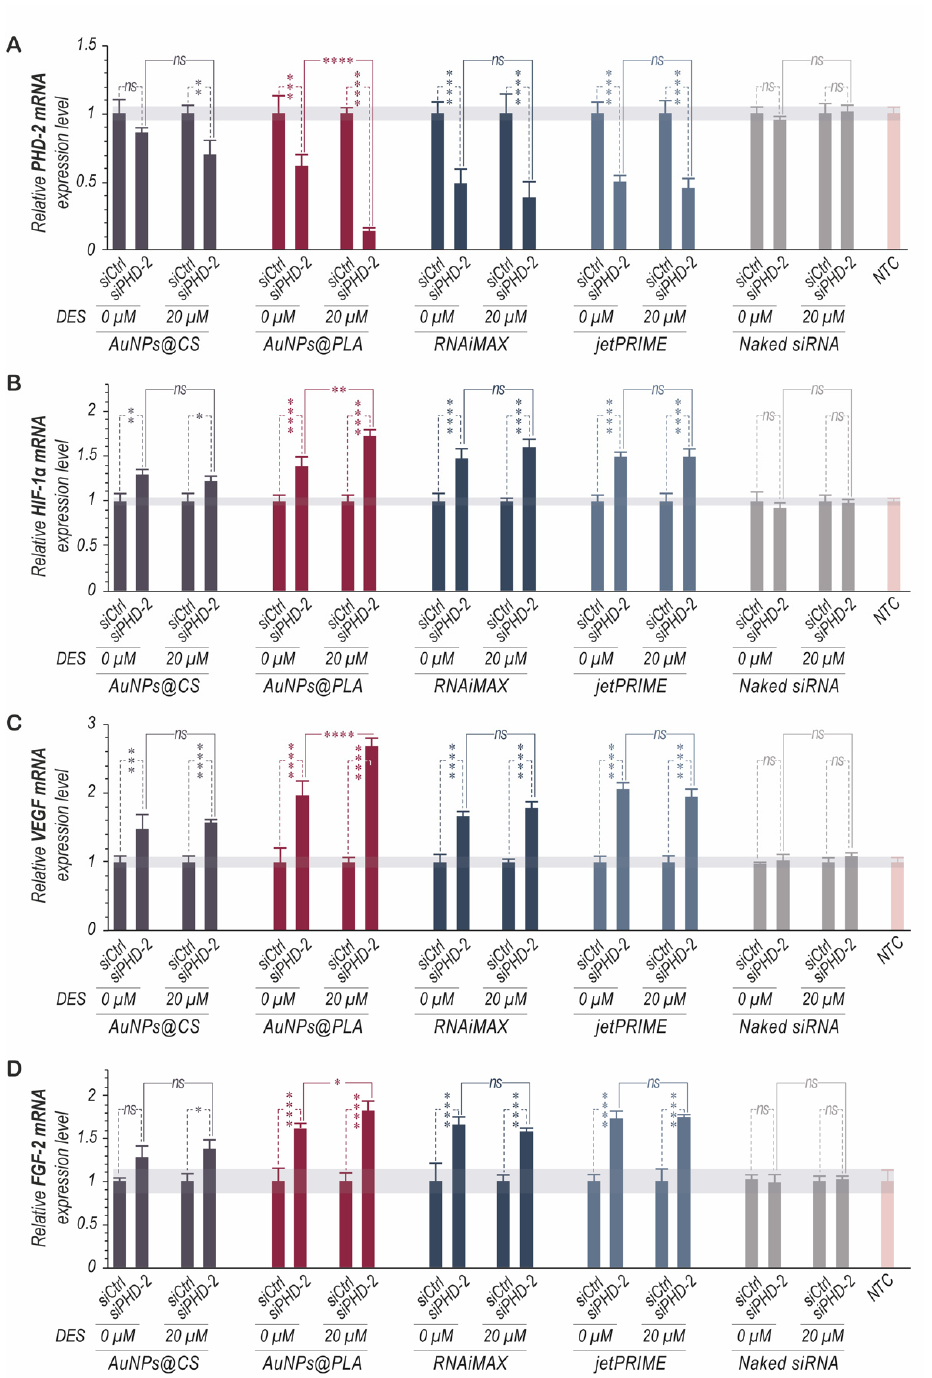
Figure 5. Knockdown of PHD-2 and its effect on the expression of angiogenic growth factors in NIH-3T3 cells. NIH-3T3 cells were incubated for 4 h with nanoformulation loaded with 30 nM non-specific siRNA (siCtrl) or siPHD-2, followed by 20 h incubation with cell culture medium without or with 20 µm DES. After another 24 h incubation in fresh cell medium, mRNA was isolated and subjected to real-time reverse transcriptase PCR analysis to determine expression of ( A ) prolyl hydroxylase domain-2 (PHD-2), ( B ) hypoxia inducible factor-1 α (HIF-1 α ), ( C ) vascular endothelial growth factor (VEGF), and ( D ) fibroblast growth factor-2 (FGF2). The results were normalized to the mRNA expression level of ß-actin and shown relative to cells transfected with siCtrl. Data are represented as the mean ± the standard deviation for a minimum of three independent experiments. (ns = not significant p > 0.05, * p ≤ 0.05, ** p ≤ 0.01, *** p ≤ 0.001, **** p ≤